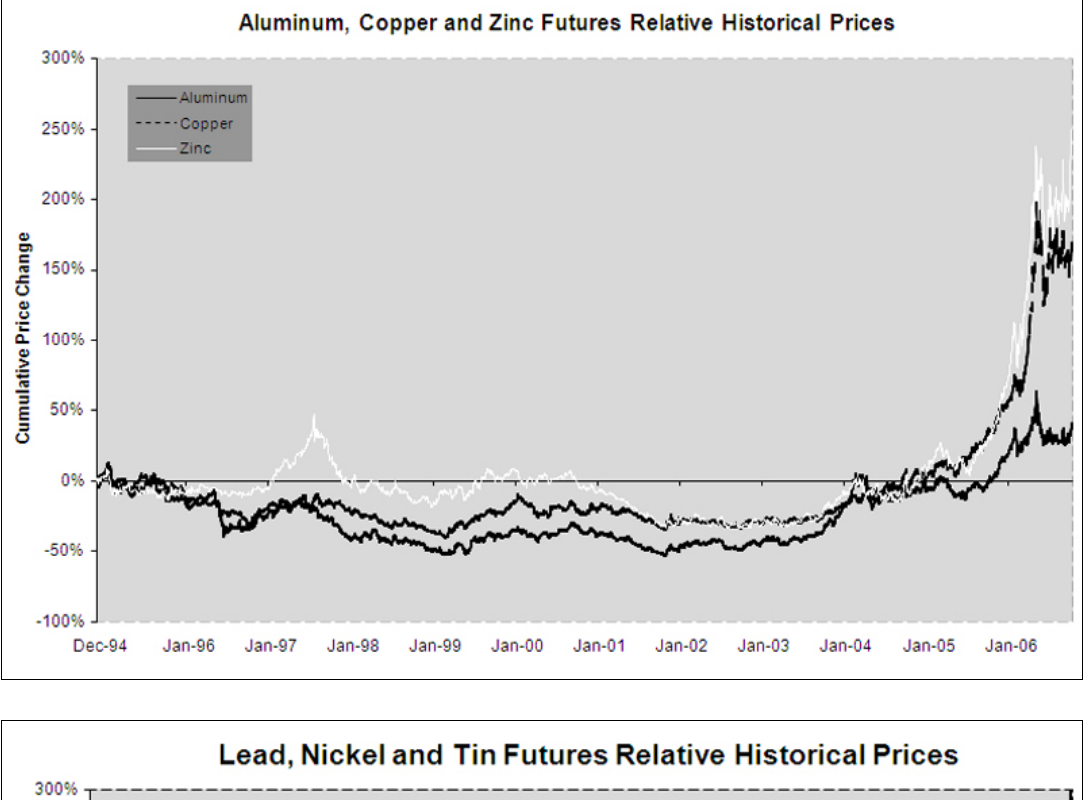
Figure 1 graphs in two panels the complete time series of data used in the study. In each panel, using the same scale, we highlight the dramatic price increase experienced by the metals markets over the study period. From these representations, we determine break points which are reported in Table